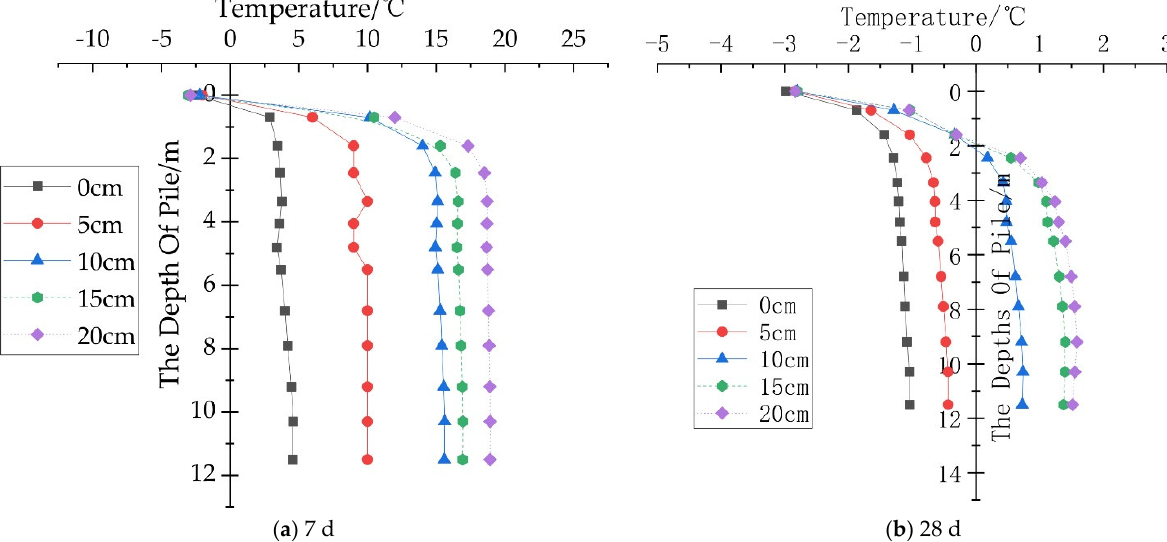
Figure 7. Temperature field of pile body with different insulation layer thickness.